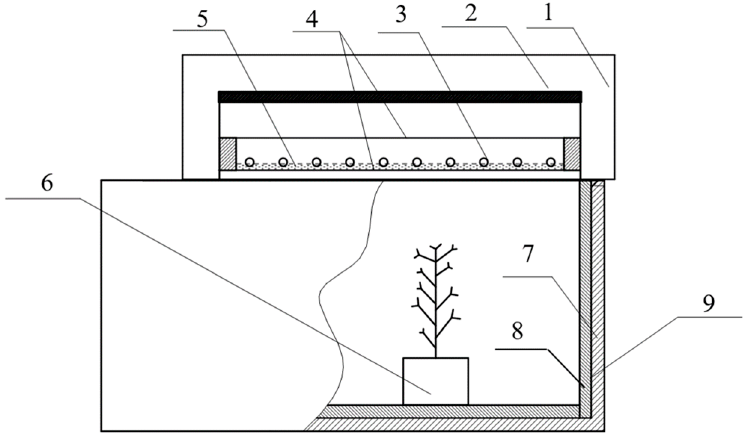
Figure 2. Structure of the frost chamber. 1. Thermal-protective coating; 2. Cold radiation source; 3. Heating wire; 4. High transmittance material; 5. Desiccant; 6. Plant sample; 7. External thermal insulation; 8. Internal thermal insulation; and, 9. Cooling plate.